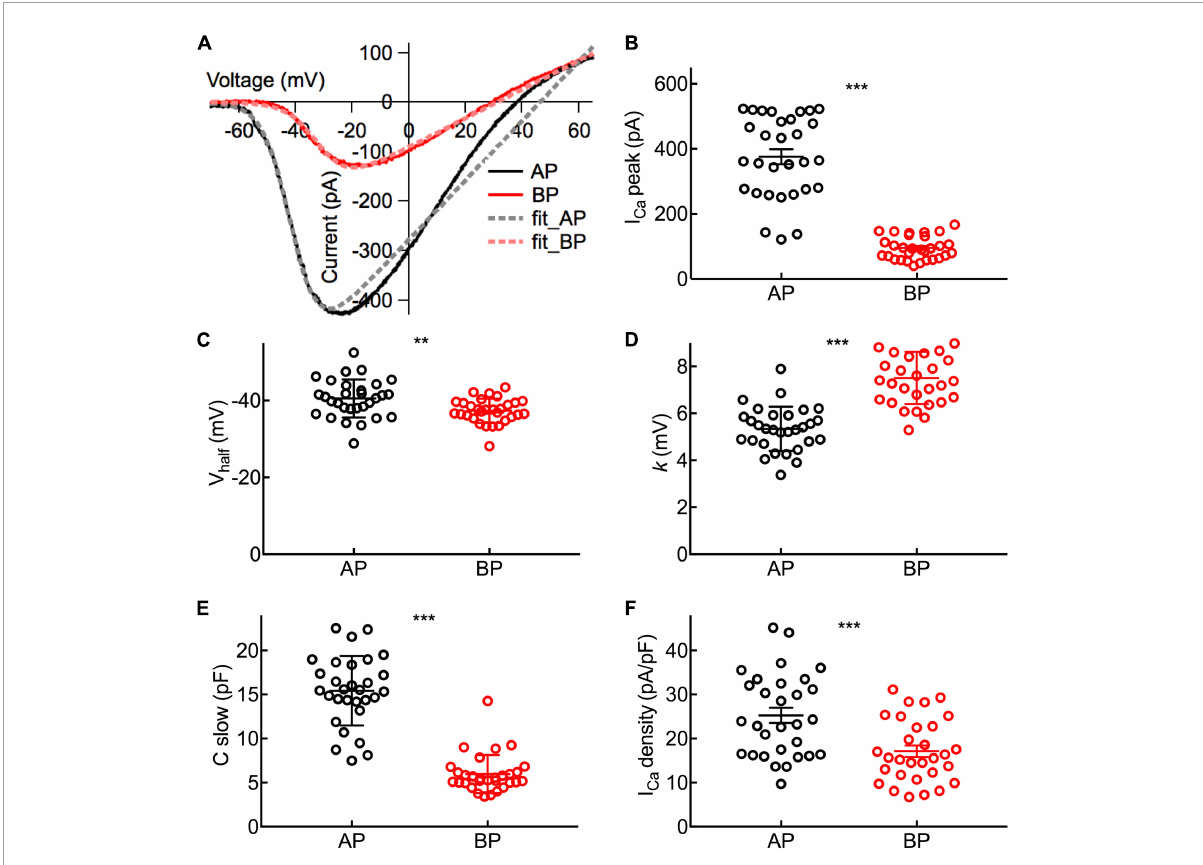
FIGURE3 Properties of I Ca in Hair Cells. (A) Representative I–V curves of the Ca 2 + current ( I Ca ) recorded from an AP and a BP hair cell in response to a voltage ramp from -90 to + 70 mV under voltage-clamp and then leak subtracted. Continuous lines are fits obtained using a Boltzmann equation (in dashed lines). (B) Amplitude of I Ca from near the peak of individual I–V curves ( I Ca peak). (C) Half activation potential (V half ). (D) Slope of Ca 2 + activation ( k ). (B–D) : The Ca 2 + current in AP hair cells has a larger peak amplitude ( I Ca peak), a more negative half-activation voltage (V half ), and a steeper voltage dependency ( k ). (E) The analysis of C-slow, which is deemed as the baseline membrane capacitance of hair cells. (F) Ca 2 + current density calculated by I Ca peak/C-slow. Data are presented as the mean ± SEM. ** means p < 0.01 and *** means p < 0.001, unpaired Student’s t -test; n = 30 hair cells for both AP and BP